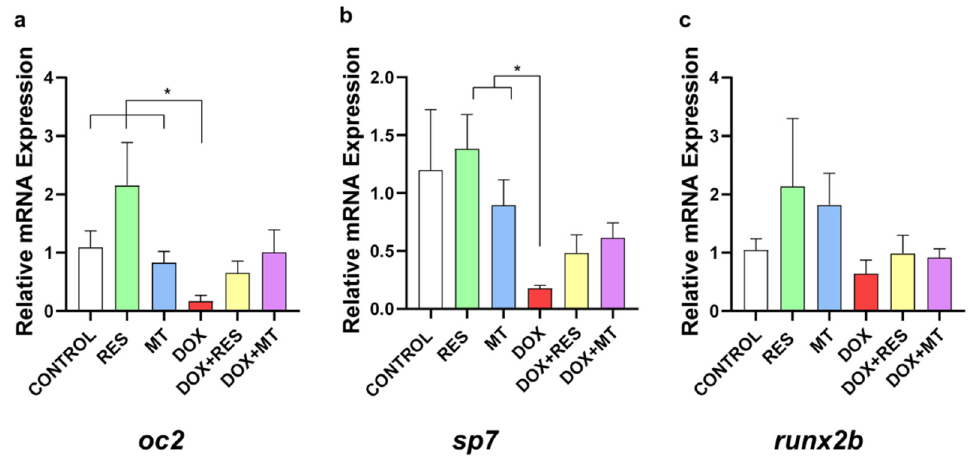
Figure 7. Doxorubicin affects osteoblastic markers. mRNA expression of osteoblast differentiation markers on zebrafish fed with resveratrol (RES), MitoTEMPO (MT) and doxorubicin (DOX) supple- mented microdiets, alone or in combination; osteocalcin 2 ( oc2 ) ( a ), osterix/sp7 (sp7) ( b ) and runx2b ( c ). Levels of significance were calculated using Student’s t -test [* p ≤ 0.05] [N = 10 × 4].